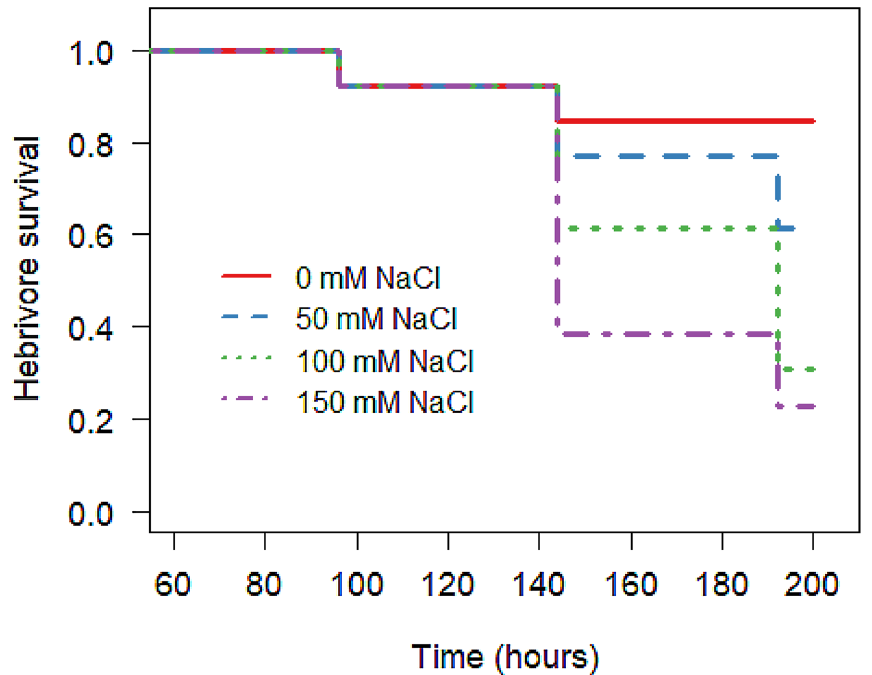
Figure 3. Effects of sodium chloride solution (0, 50 100, 150 mM NaCl) treated diet on Spodoptera exigua